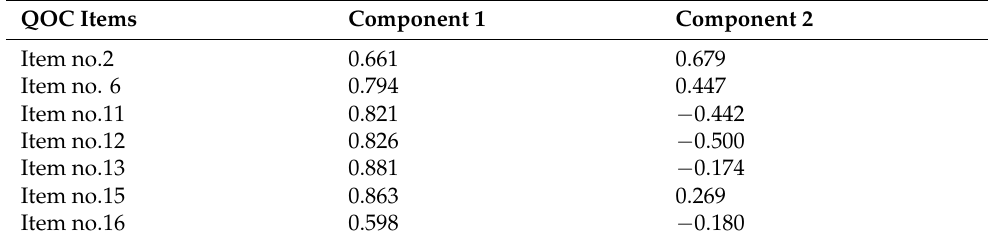
Table 2. Rotated Component Matrix for Exploratory Factor